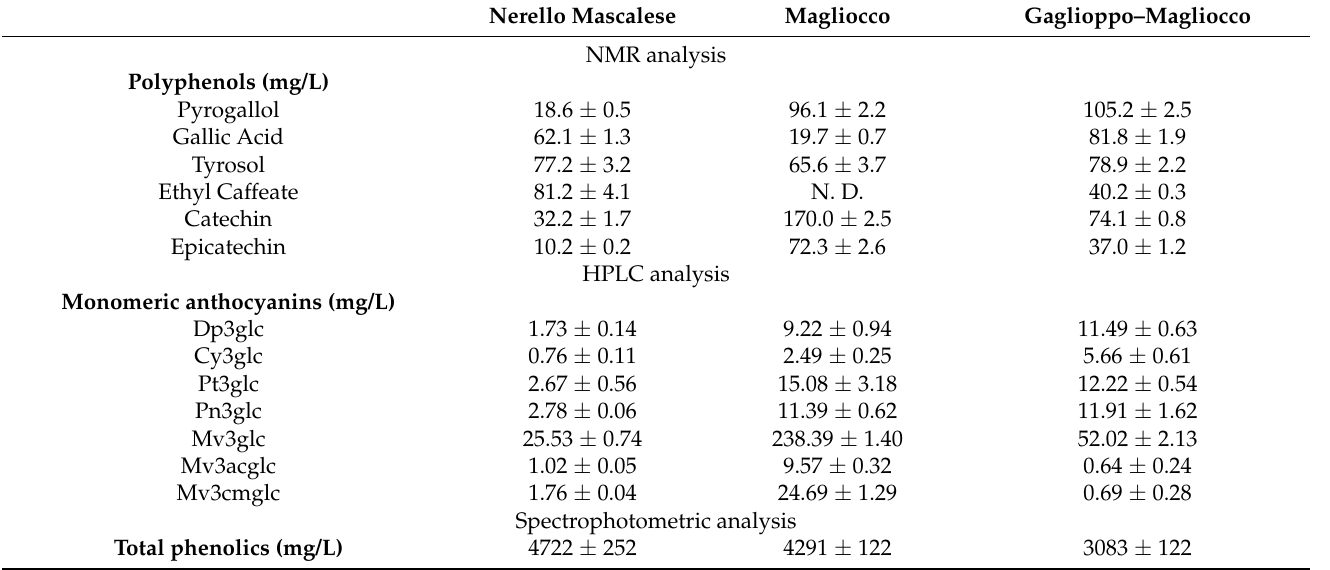
Table 1. Chemical characterization of wines. Polyphenols in Gaglioppo–Magliocco, Magliocco, and Nerello were identified by NMR. Concentration of monomeric anthocyanins were determined by HPLC analysis; total phenolics were determined by spectrophotometric methods. Their quantifications are expressed as mg/L. All data were expressed as the mean ± standard deviation (SD) of three replicates. Statistical analysis was performed through an analysis of variance (ANOVA), followed by the Tukey’s multiple comparisons. Statistical significance was attributed to p -values <